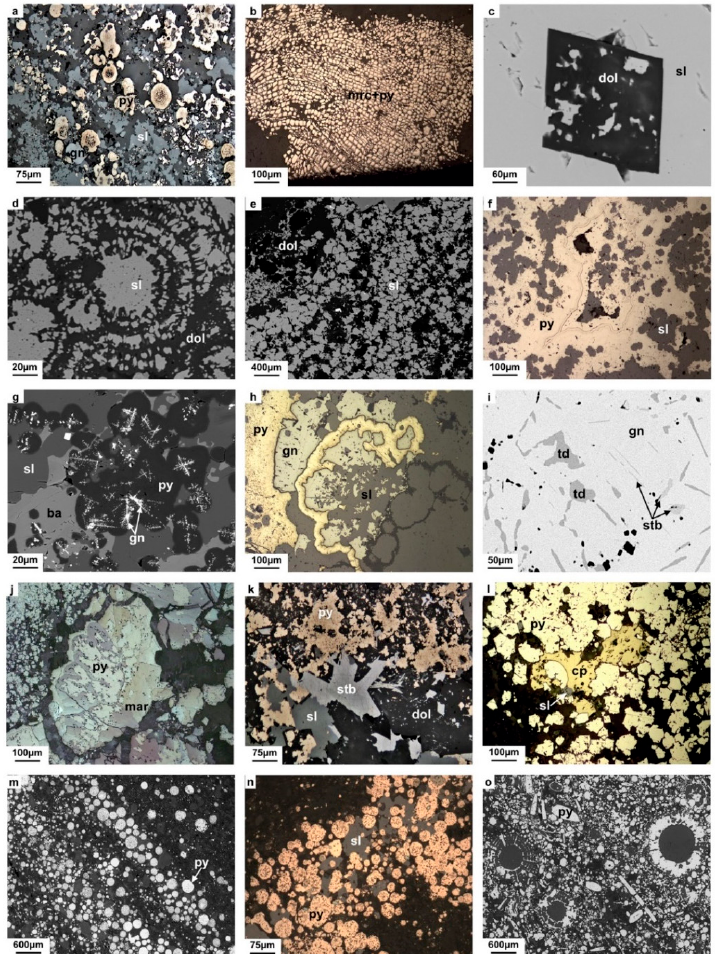
Figure 5. Reflected light and backscattered electron (BSE) images of the Tara Deep deposit ( a – l ) and the overlying UDL-hosted geochemical halo ( m – o ). ( a ) Relicts of framboidal pyrite (py) partially replaced by colloform pyrite and associated with sphalerite (sl) and galena (gn); ( b ) marcasite (mrc) and pyrite replacing wood cells; ( c ) euhedral dolomite (dol) crystal partially infilled and replaced by sphalerite; ( d ) dolomite replaced by colloform sphalerite; ( e ) subhedral sphalerite aggregates associated with dolomite; ( f ) sphalerite filling open spaces in colloform pyrite; ( g ) skeletal galena included in colloform pyrite; ( h ) interstitial galena and sphalerite in colloform pyrite; ( i ) fine tetrahedrite (td) and stibnite (stb) inclusions in galena; ( j ) marcasite partially corroded, replaced and overgrown by pyrite; ( k ) stibnite aggregates intergrown with sphalerite; ( l ) interstitial chalcopyrite (cp) in recrystallized pyrite; ( m ) laminated framboidal pyrite hosted in lutites; ( n ) laminated framboidal pyrite replaced by sphalerite; and ( o ) pyritized fossils (mainly radiolaria) in a calcarenite